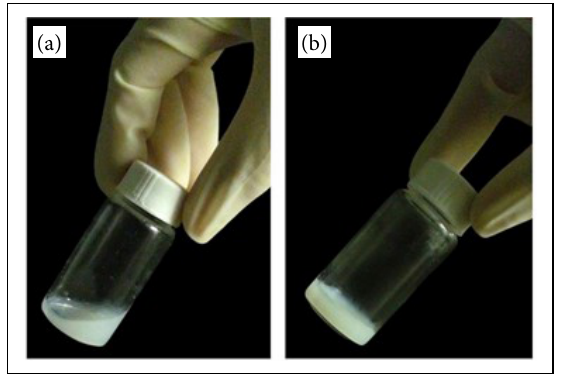
Figure 2 - Hydrogel aspect from decellularized porcine skin. (a) Hydrogel at 4 °C in liquid state used in the experiments. (b) Hydrogel at 37 °C in a swollen state and used in cell culture experiments (n =